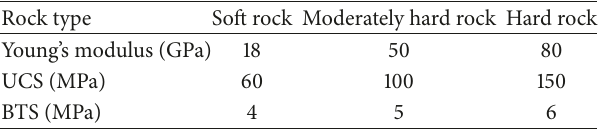
Table 2: Parameters of three types of